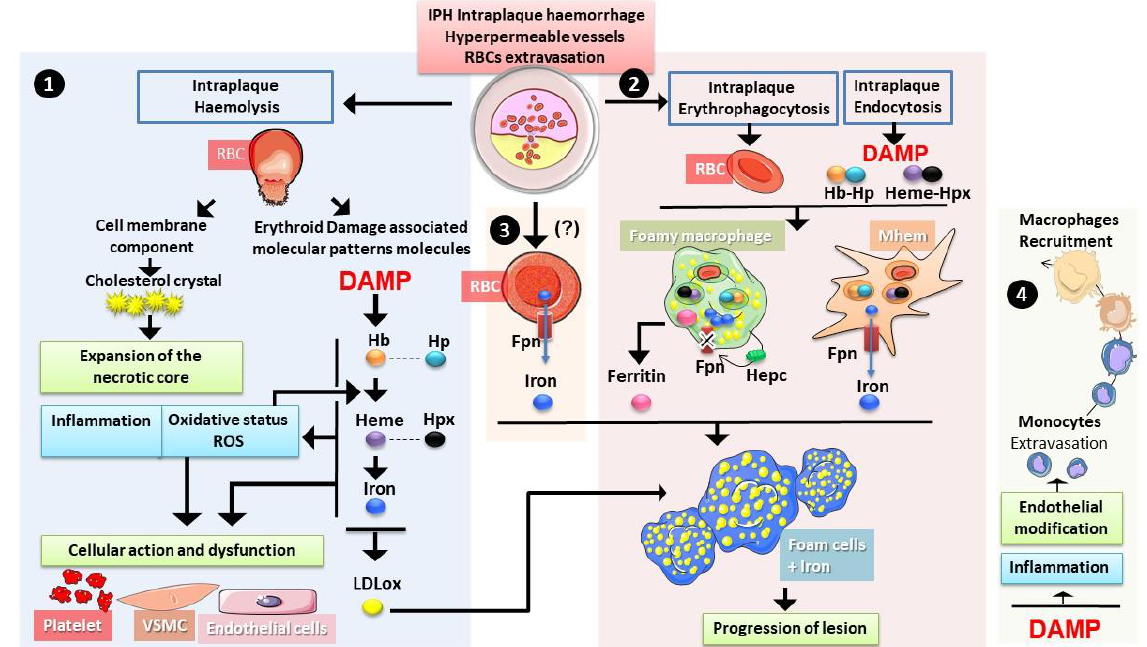
Figure 6. Erythrocytes in intraplaque haemorrhage. During intraplaque haemolysis 1. and rupture lysis, RBCs liberate both cholesterol and erythroid damage-associated signalling molecule patterns ((DAMPs) haemoglobin Hb, heme and iron), both contributing to the expansion of the necrotic core and to the increase in oxidative stress and inflammation. Such changes could have an impact on the function of endothelial cells, vascular smooth muscle cells (VSMC) and platelets. Haemoglobin and iron can promote the oxidation of LDL particles accelerating the foam cell differentiation. Erythrophagocytosis as well as endocytosis of heme/hemopexin and haemoglobin/haptoglobin complexes 2. also occurs in the plaque with an important role of macrophages. The haemorrhage-associated macrophages (Mhem) are prone to recycling iron from both erythrophagocytosis and heme containing-complexes endocytosis, whereas foamy macrophages (Mox) tend to accumulate iron with lipids. Autocrine expression of hepcidin (Hepc) seems to play a role in iron retention. Ferritin secretion by these cells has been reported. Another source of iron could exist directly from erythrocytes via the expression of ferroportin (Fpn) 3. Both iron and ferritin present in the plaque with oxidised low-density lipoprotein (oxLDL) could trigger the formation of foam cells, promoting the progression of the lesion and the instability of the plaque. In addition, 4. erythroid DAMPs were shown to increase expression of adhesion molecules by endothelial cells and to have proinflam- matory effects. Both phenomena contribute to the recruitment of more monocytes/macrophages in the plaque.